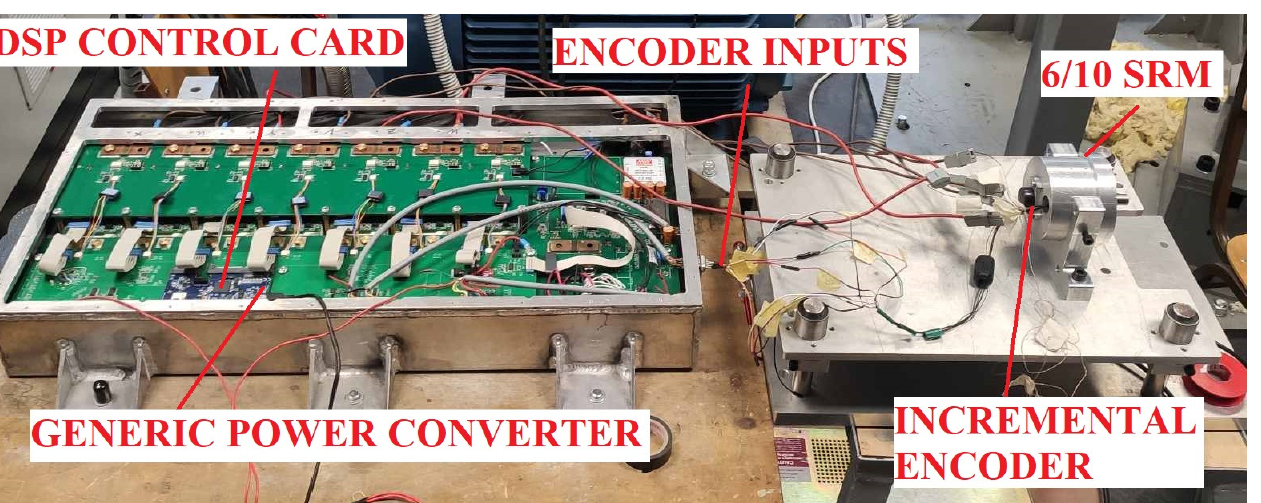
Figure 31. Test bench for dynamic no-load tests of 6/10 SRM prototype.